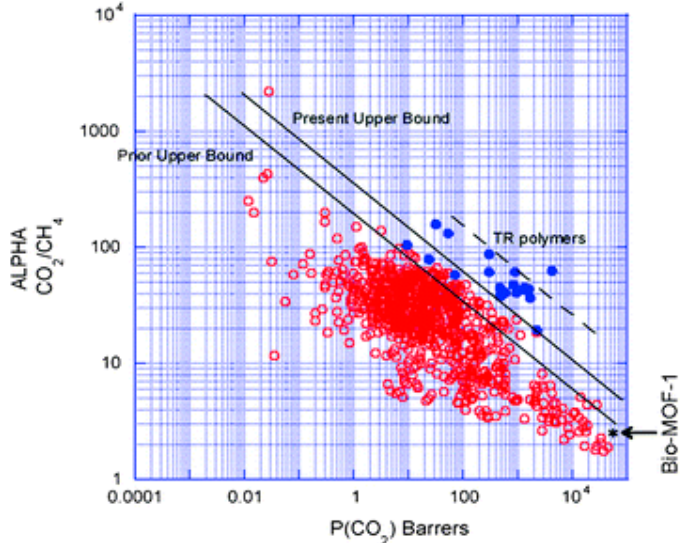
Figure 53. Robeson plot for CO 2 /CH 4 mixtures. For comparison, data point for a Bio-MOF-1 membrane is shown (adapted with permission from ref. [149]).